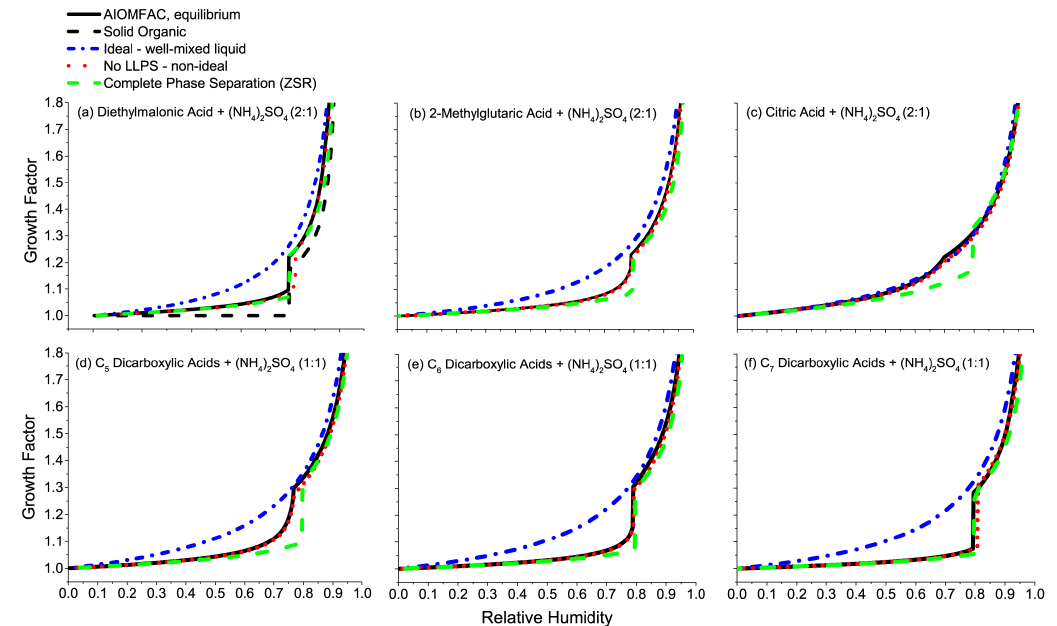
Figure 4. Comparison of simplified thermodynamic assumptions to the full AIOMFAC hygroscopic growth calculations for the multi- component systems for which we expect observed water-uptake behavior to be governed by thermodynamic equilibrium conditions. Or- ganic:inorganic dry mass ratios, which can substantially influence the extent to which non-ideal interactions affect water uptake, are given in parentheses. The performance of the simplified modeling approaches varies across the systems with variations in phase behavior. Disagree- ment between the full AIOMFAC-based equilibrium calculations and the simplified models is greatest at low to moderate RH (RH = 20–